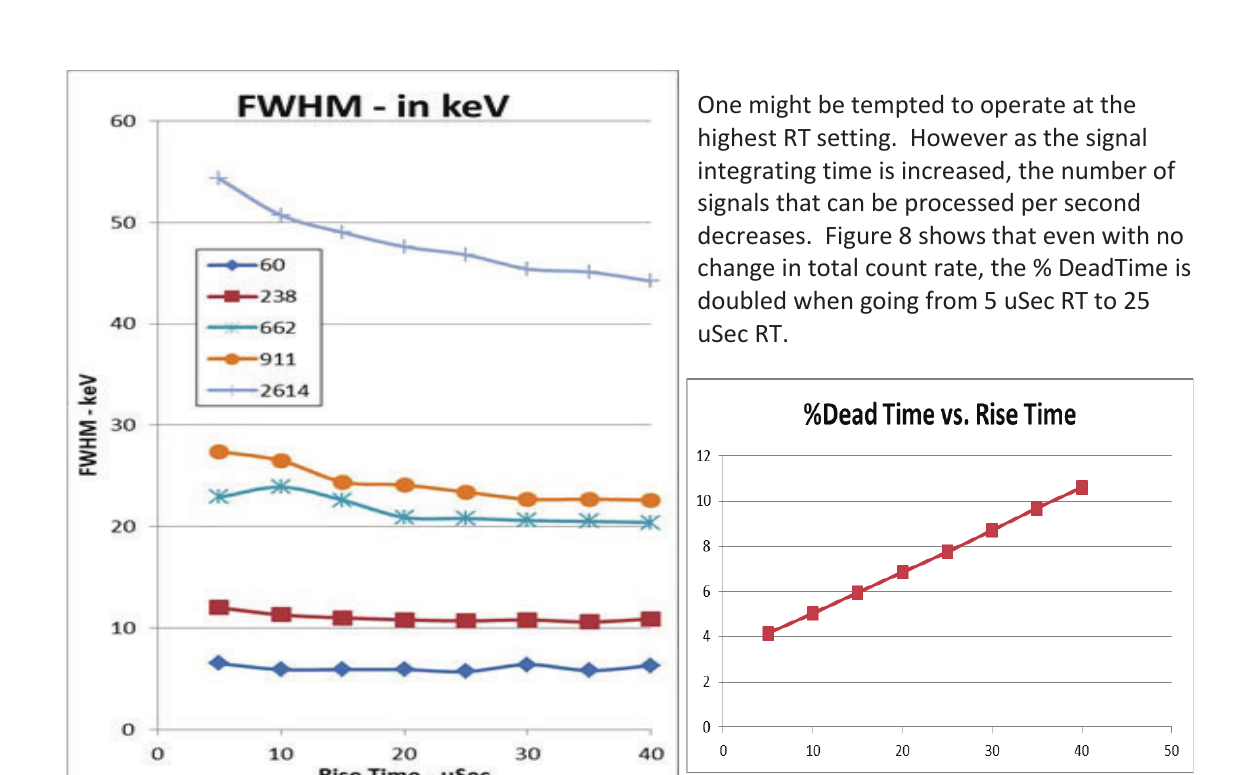
Figure 8 Percent dead time [vertical axis] as the Rise Time is changed [horizontal axis].